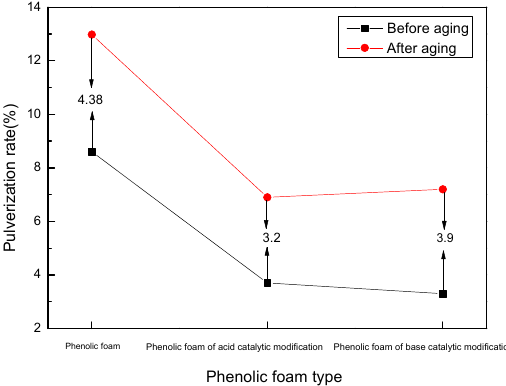
Figure 7. Pulverization rate variation curve of phenolic foam and modified phenolic foam before and after aging.